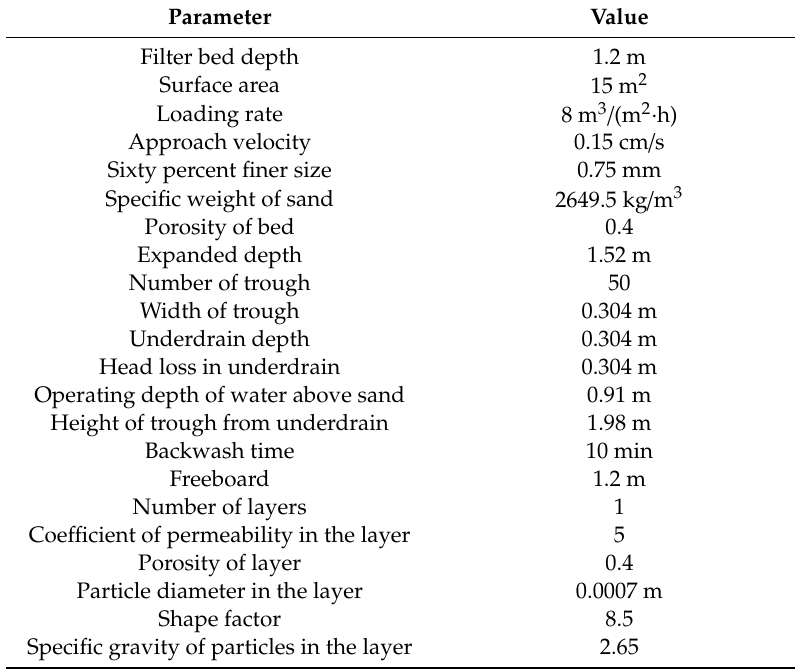
Table 3. The characteristics of sand filtration process